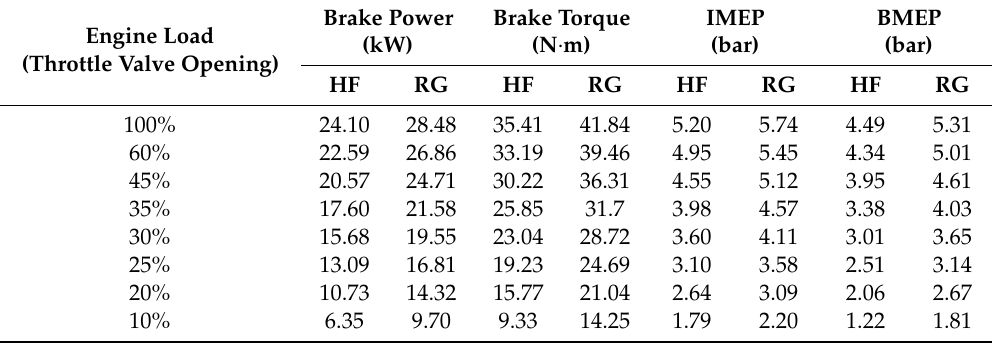
Table 19. Simulation results of engine load characteristics (engine speed = 6500 r / min).